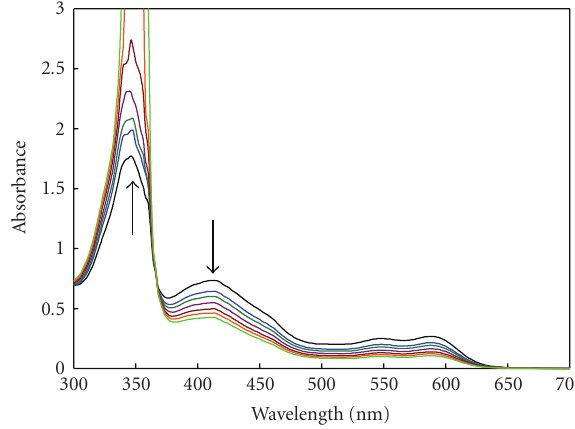
Figure 2: Absorption spectra of OMZ-DDQ complex as a function of time. The complex was generated by carrying out the reaction of OMZ (20 . 00 μ gmL − 1 ) with DDQ (0 . 40 μ gmL − 1 ) in acetonitrile at 25 ± 2 ◦